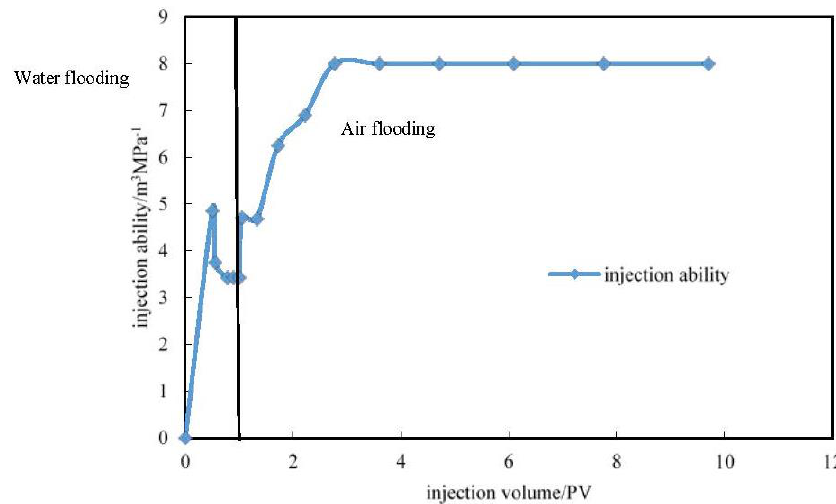
Figure 7. Injection ability and multiple injection relationship diagrams.